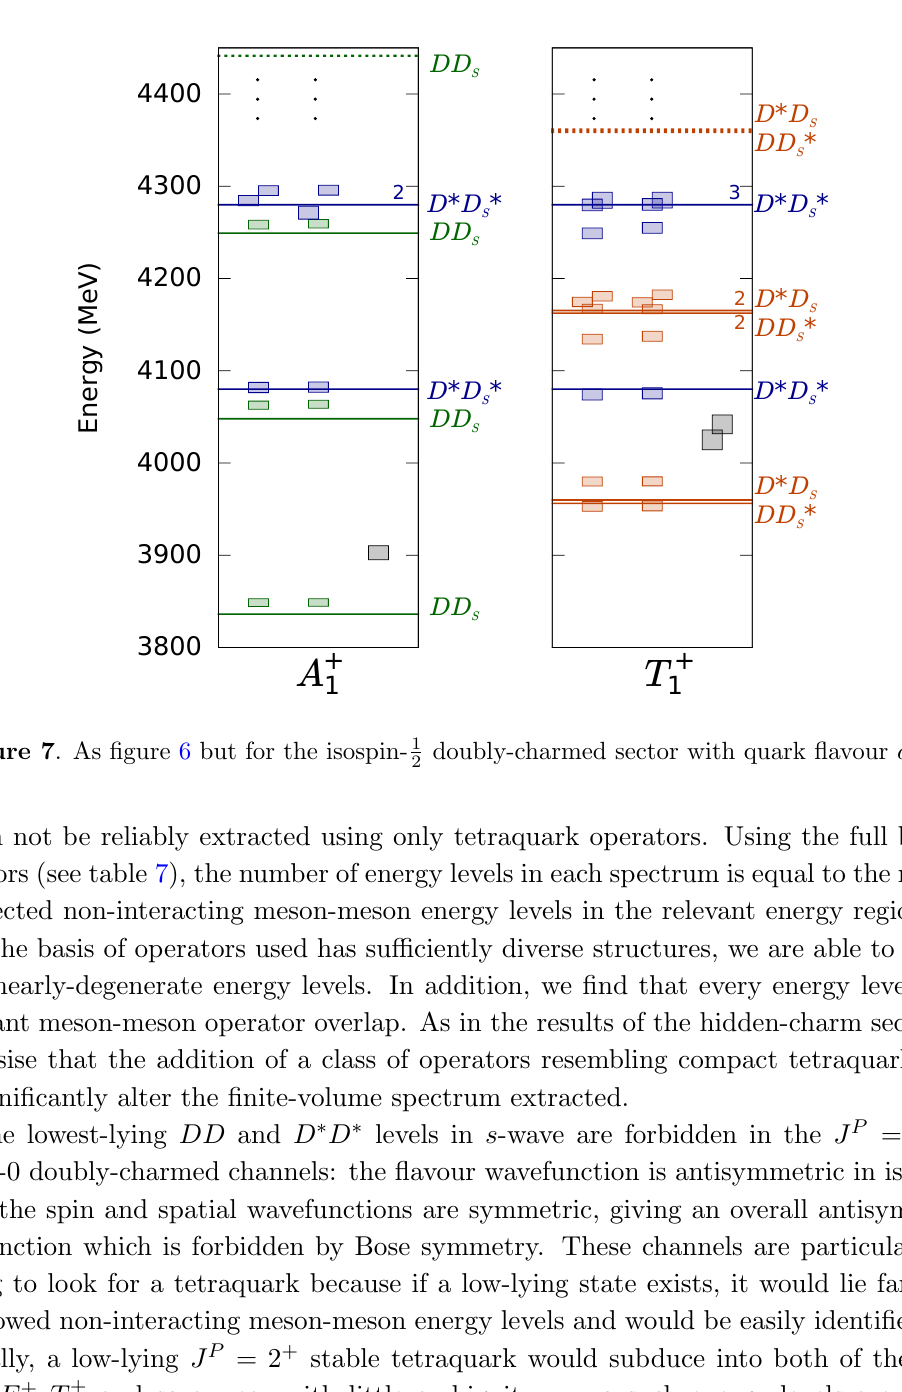
tra can not be reliably extracted using only tetraquark operators. Using the full basis of operators (see table 7), the number of energy levels in each spectrum is equal to the